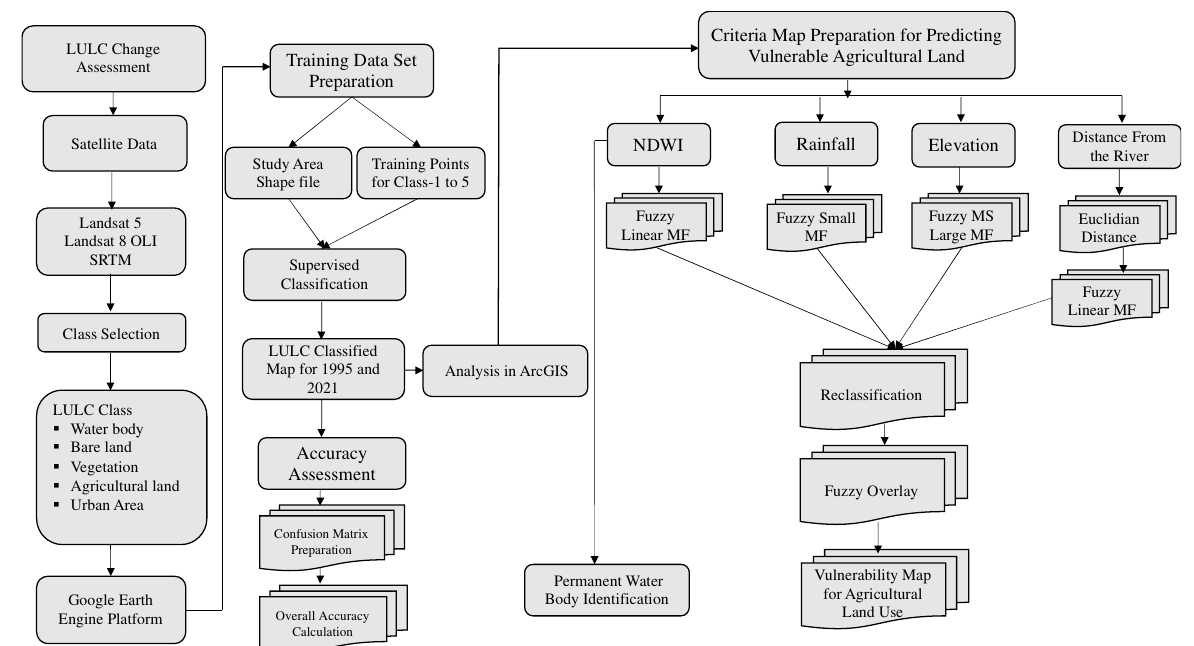
Figure 2. Research framework for LULC change assessment for predicting vulnerable agricultural lands.